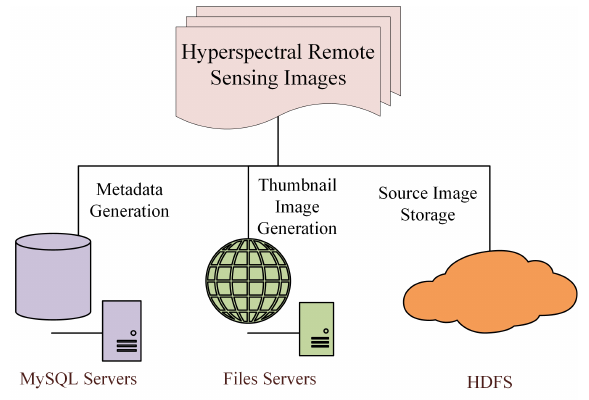
Figure 2. The storage framework structure of HSI repository.